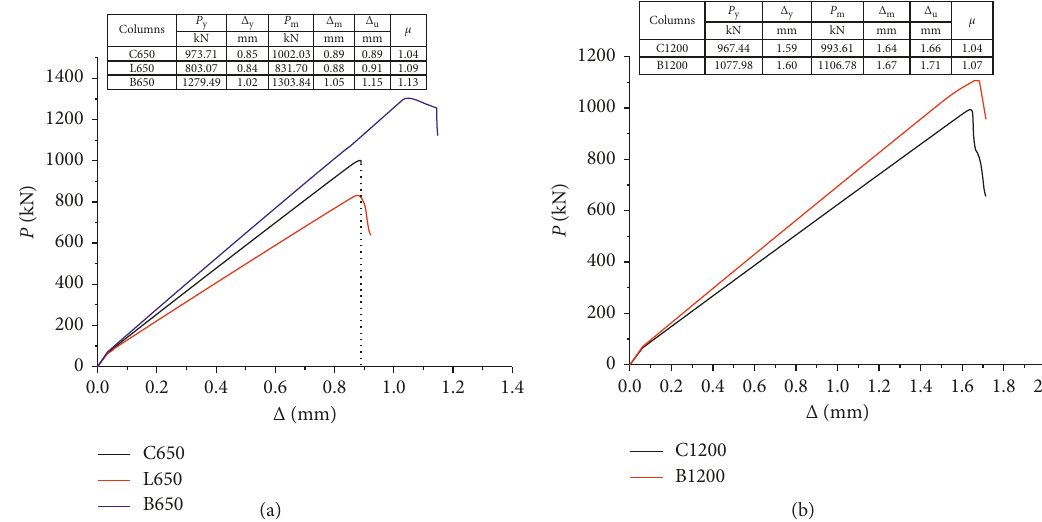
Figure 22: P - Δ curves of models: (a) 650mm column models; (b) 1200mm column